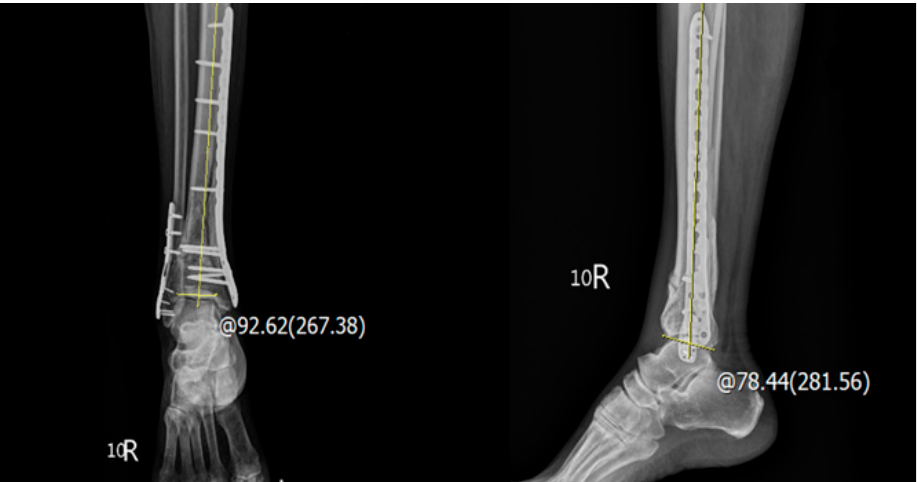
Figure 2. The postoperative angle measurement: LDTA, the distal tibial articular surface and the anatomical axis of the tibia in the coronal plane (normal values 89° ± 3°); ADTA, the mechanical axis of the tibia and the joint orientation line of the ankle in the sagittal plane (normal values 80° ± 3°).